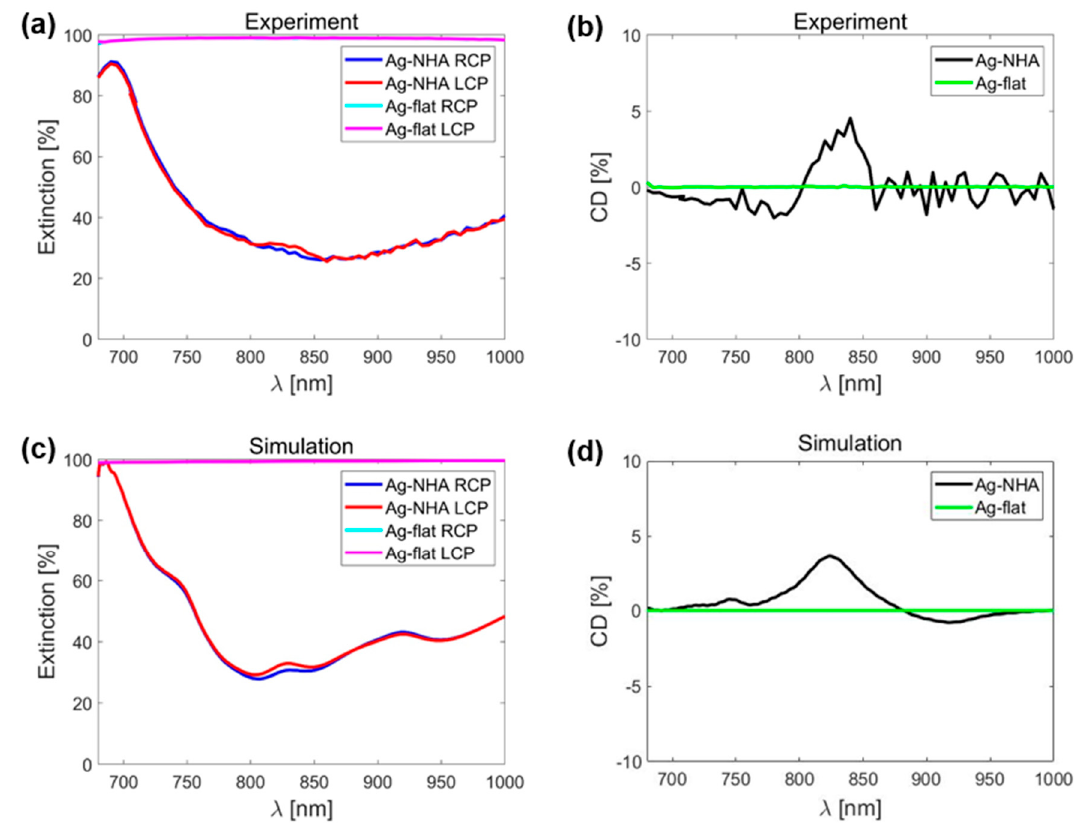
Figure 3. Experimental results for Ag-NHA and Ag-flat: ( a ) extinction spectra for RCP and LCP excitation, and ( b ) CD. Simulations for Ag-NHA and Ag-flat: ( c ) extinction spectra for RCP and LCP excitation, and ( d ) CD.